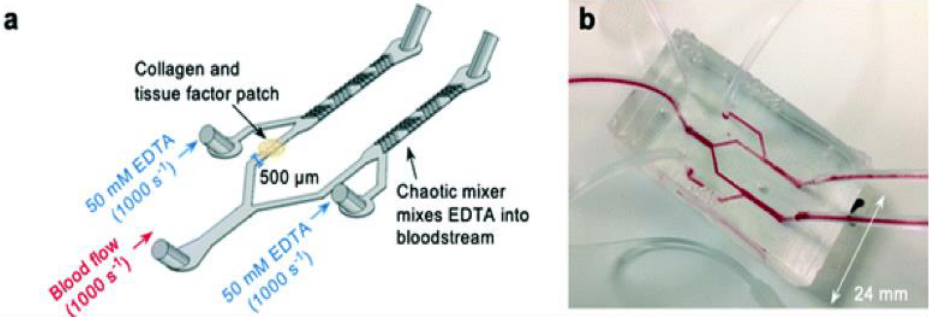
Figure 3. Novel thrombosis-on-a-chip device to measure occlusion time. ( a ) A schematic illustration of the ‘EDTA-quenched’ device; ( b ) a photograph of the device. Reproduced from Ref. [33] with permission from the Royal Society of Chemistry.